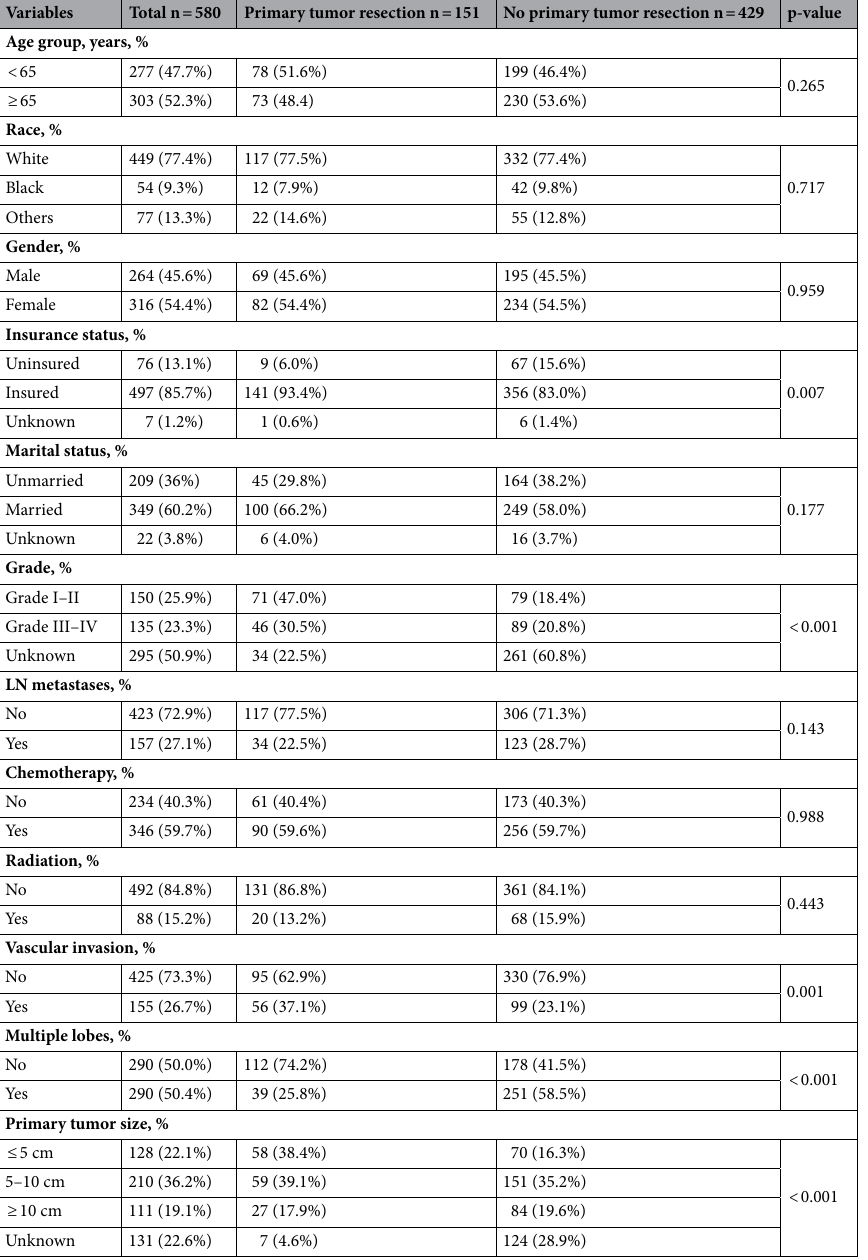
Table 1. Baseline characteristics of patients with multifocal intrahepatic